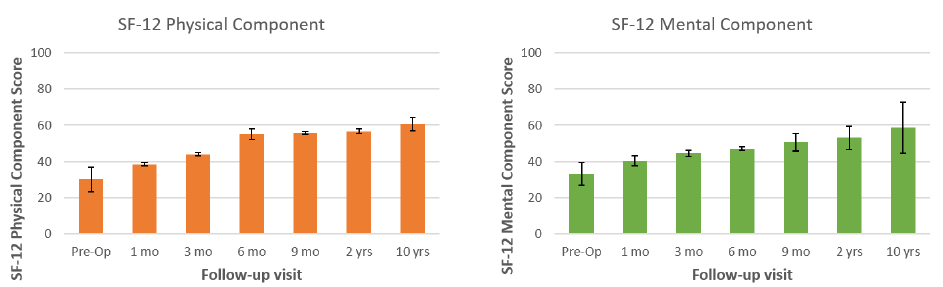
Figure 1. Pre- and post-treatment self-reported VAS scores for back pain ( n = 3, 10 years follow-up) are shown at 1, 3, 6, 9, months, 2 years and 10 years after surgical treatment with percutaneous posterior fixation.